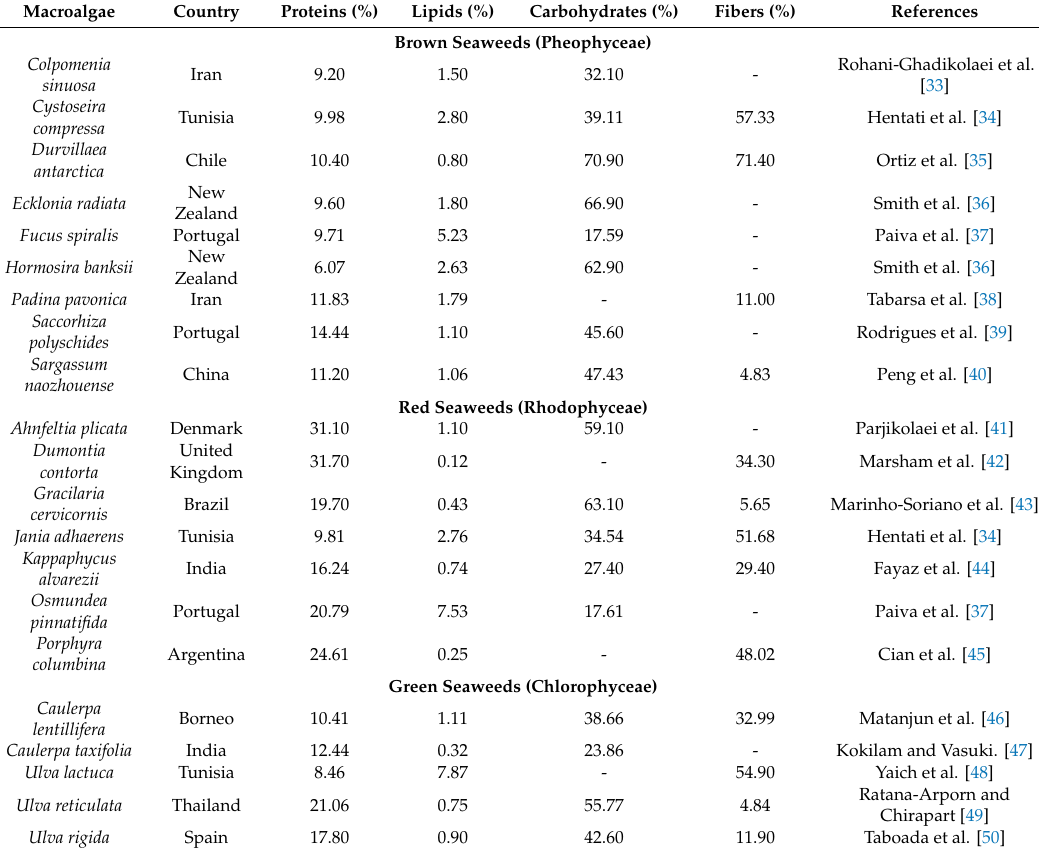
Table 1. Physicochemical composition of